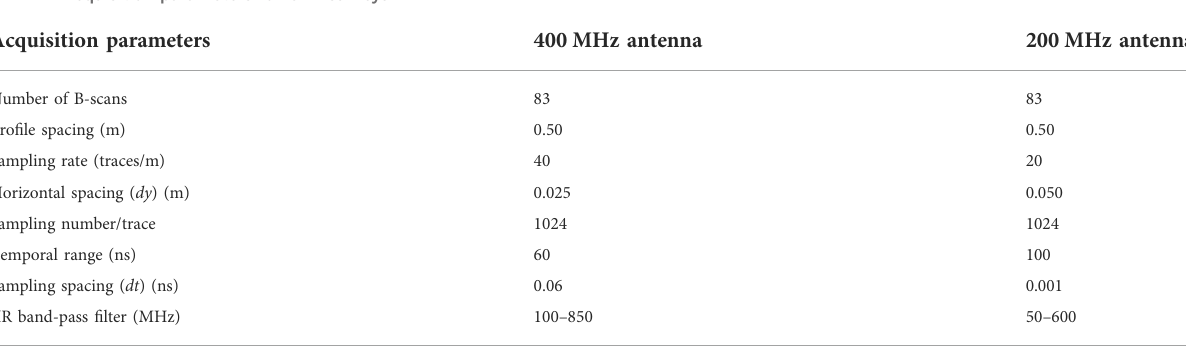
TABLE 2 Acquisition parameters for GPR